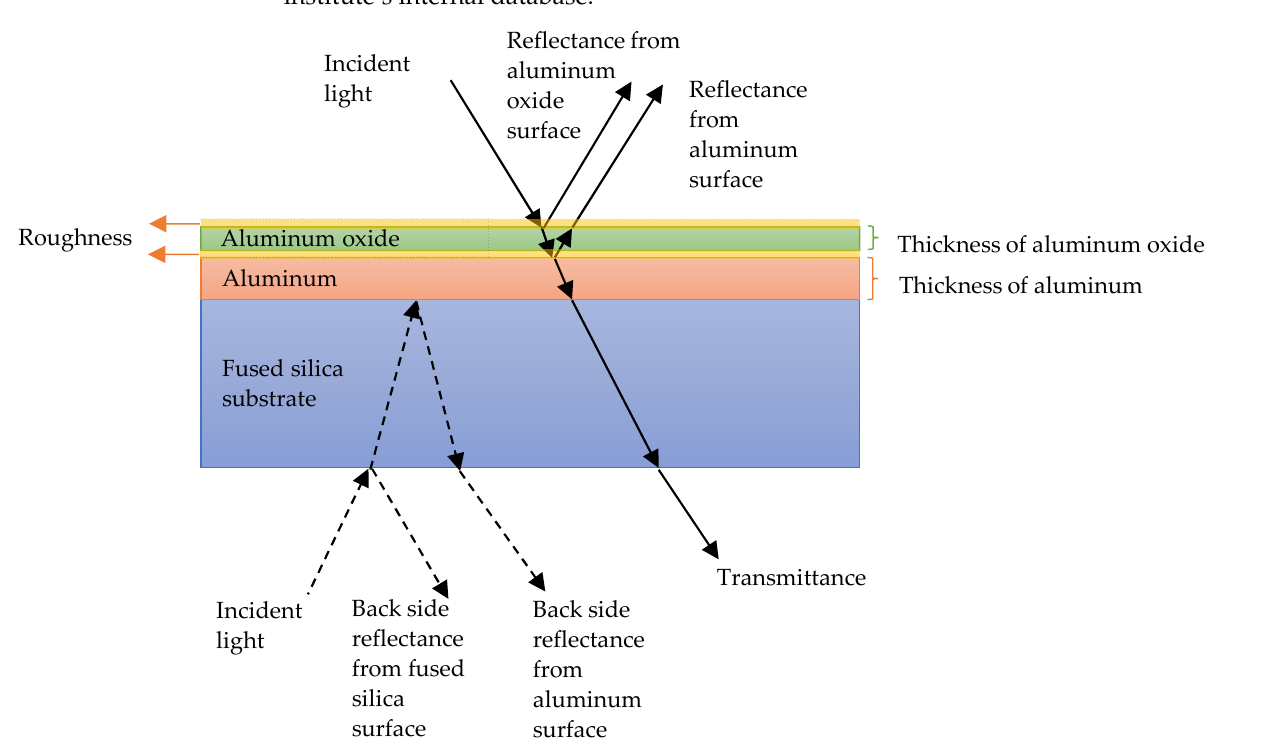
Figure 2. Layer model. Yellow regions denote interface roughness and arrows indicate beam prop- agation. Table 4. Results of XRR investigations.